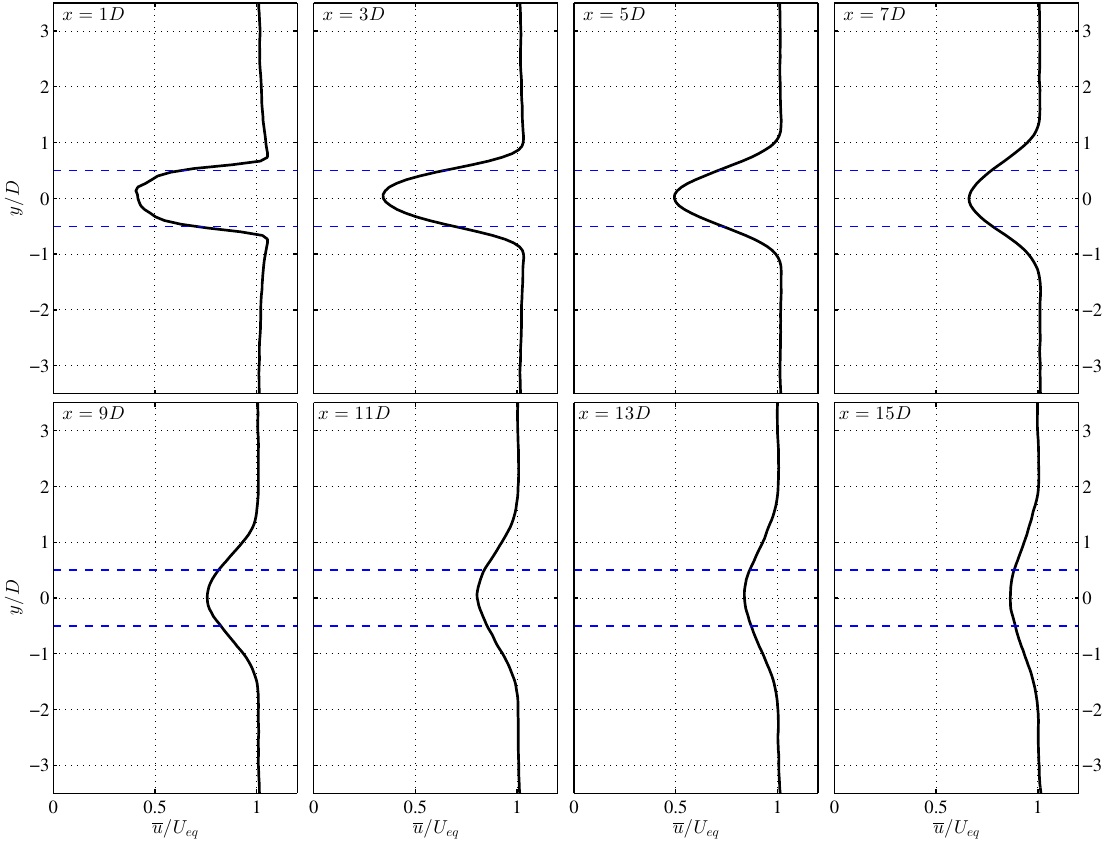
Figure 9. Horizontal-spanwise profiles of the normalized mean streamwise velocity ( u / U eq ) in the x - y plane at the equator height of the turbine at different downstream positions. The blue horizontal dashed lines show the extent of the